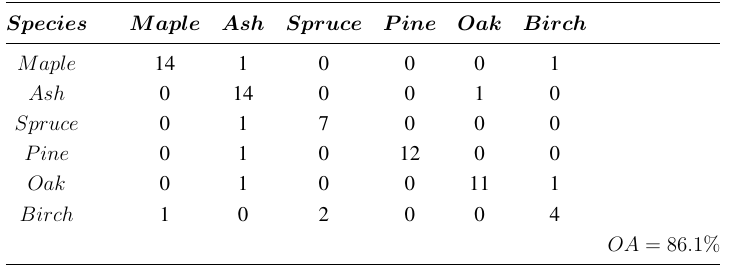
Table 4. The C5.0 decision tree classification results with all information (Spectral, texture, profiles etc .)